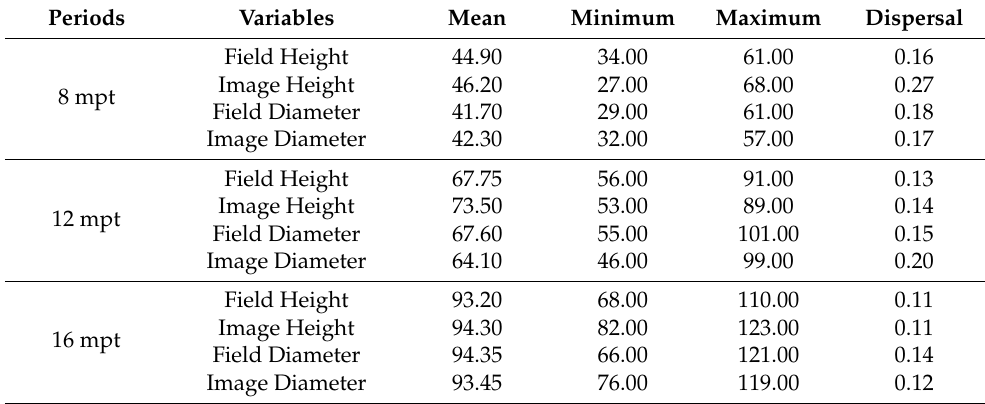
Table 1. Descriptive statistics, in centimeters (cm), for height and crown diameter variables measured in the field and by aerial images for the three periods of